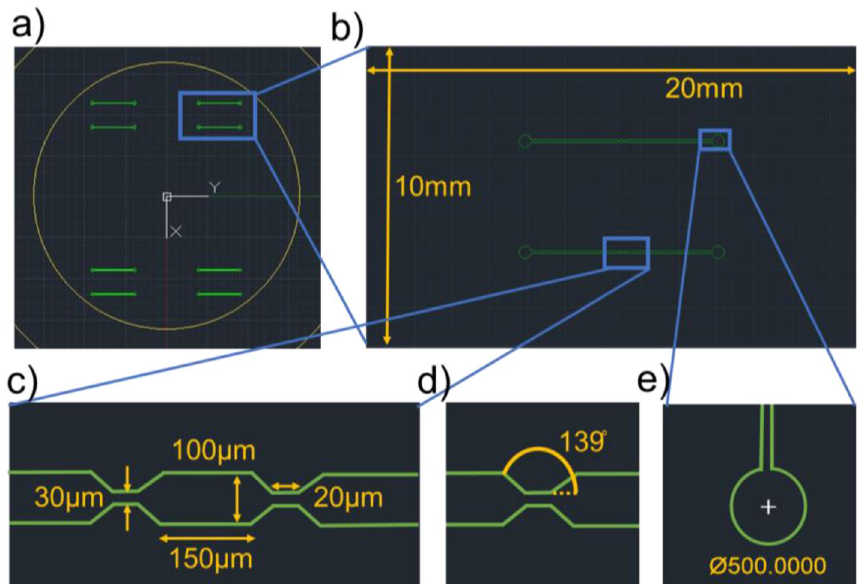
Figure 2. ( a ) The AutoCAD layout of microfluidic channel photomask for Design M biochip fabrication, ( b ) Single final chip microchannels with 20 × 10 mm length × width, ( c ) The detailed dimensional explanation of constricted microchannel mask layout, ( d ) The inclination angle between a microfluidic channel and the constricted channel is 139°, ( e ) The inlet and outlet hole